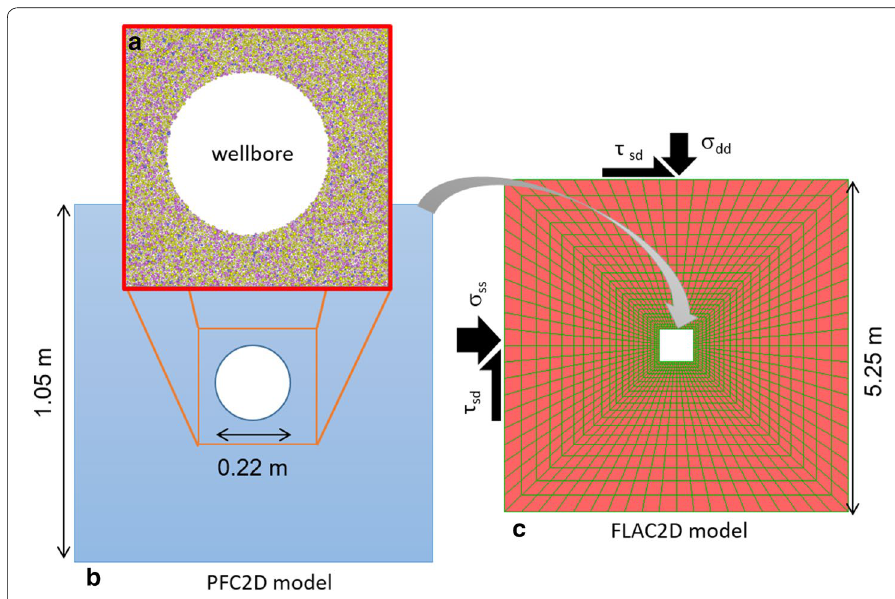
Fig. 8 FLAC/PFC2D‑coupled model: a detail of the wellbore with particles of PFC2D; b PFC2D model (the entire extent of 1.05 by 1.05 m 2 —blue color—is discretized with particles, 141,500 in total); c FLAC model— mesh and stress